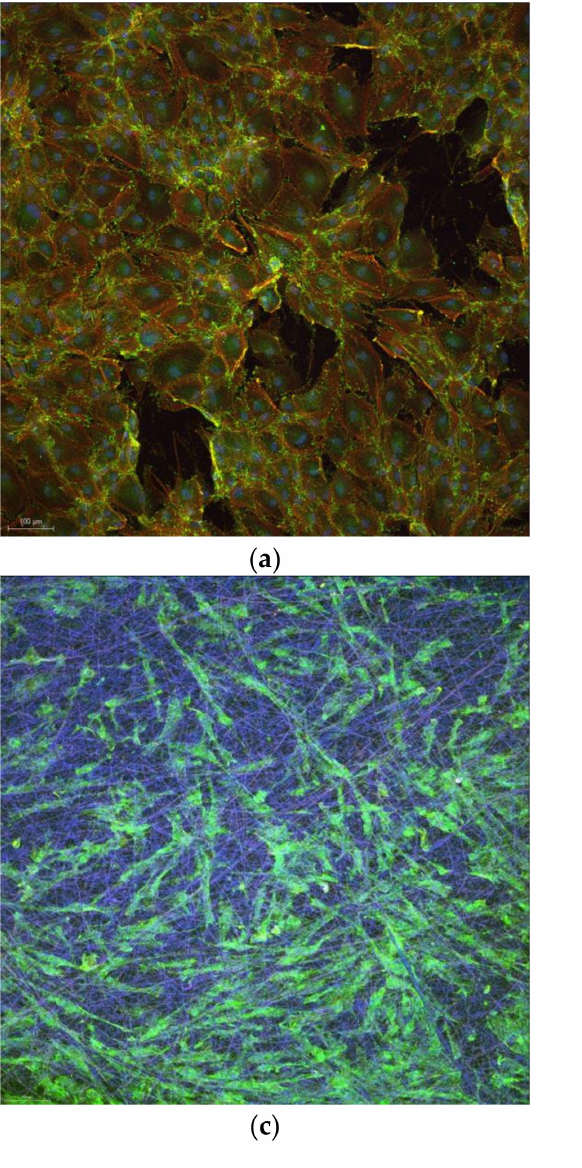
Figure 11. Confocal images of osteoblasts on the substrates after 7 days of incubation: ( a ) Polystyrene; ( b ) Titanium; ( c ) Electrospun; and ( d ) 3D